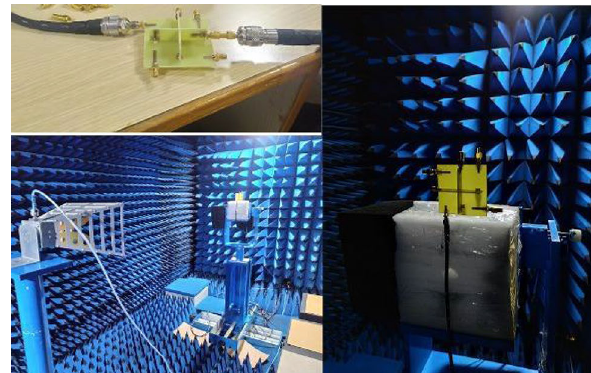
Figure 11. Photo of fabricated antenna and measurement setup.